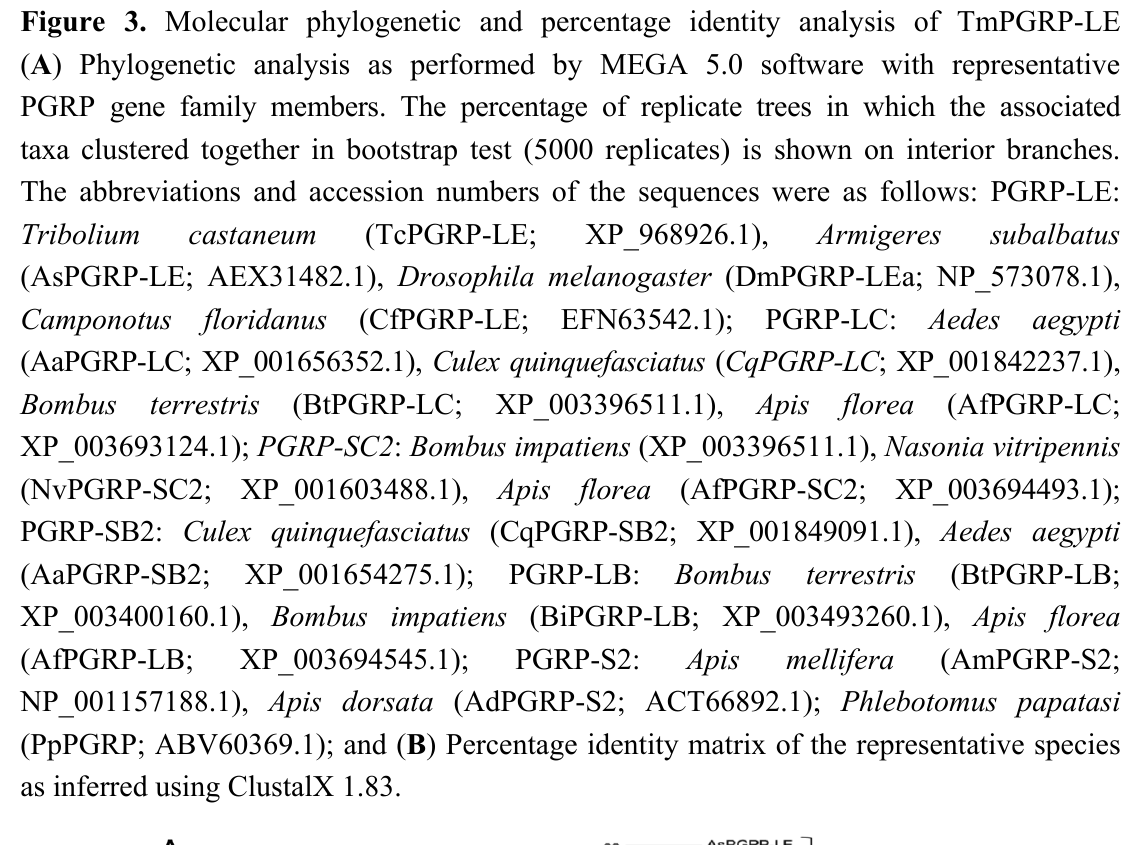
Figure 3. Molecular phylogenetic and percentage identity analysis of TmPGRP-LE ( A ) Phylogenetic analysis as performed by MEGA 5.0 software with representative PGRP gene family members. The percentage of replicate trees in which the associated taxa clustered together in bootstrap test (5000 replicates) is shown on interior